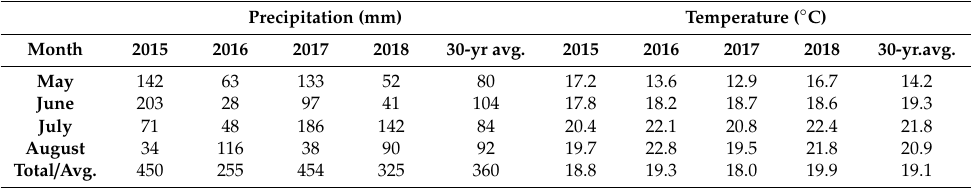
Table 5. Monthly and total precipitation and monthly and average temperature during the soybean growing season in 2015, 2016, 2017 and 2018 and the 30-year average at a University Research Farm in central New York, USA.